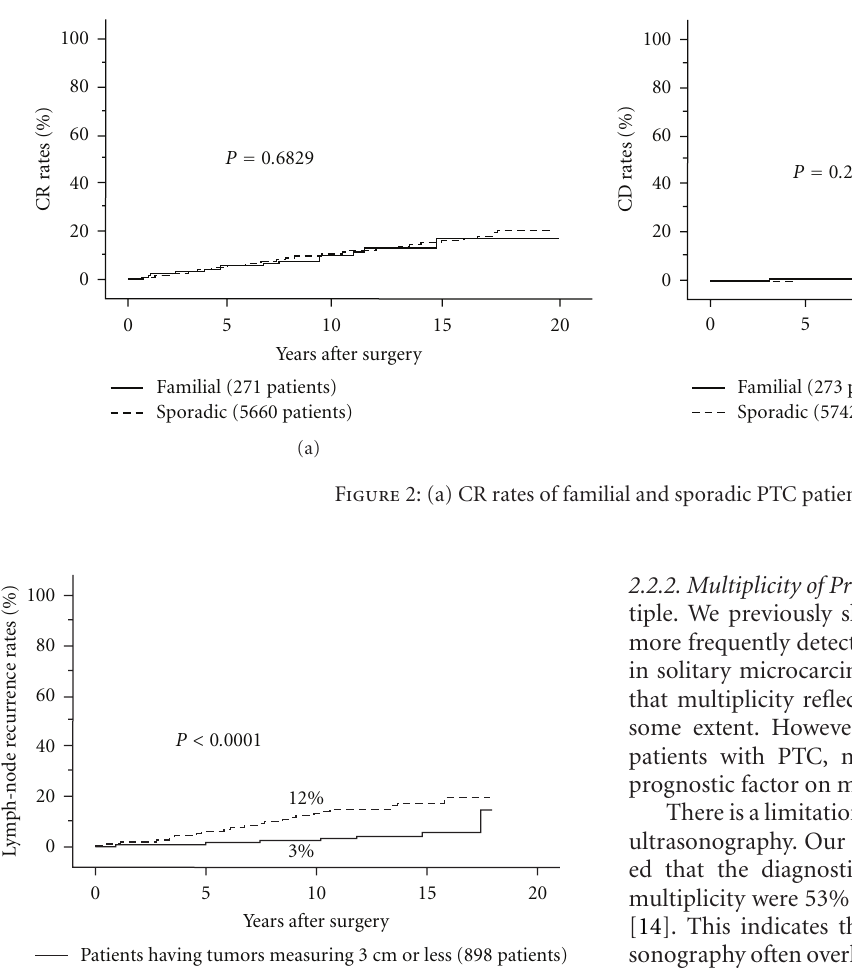
Figure 3: Lymph-node recurrence rates of PTC patients having tumors larger than 3cm and those having tumors measuring 3cm or